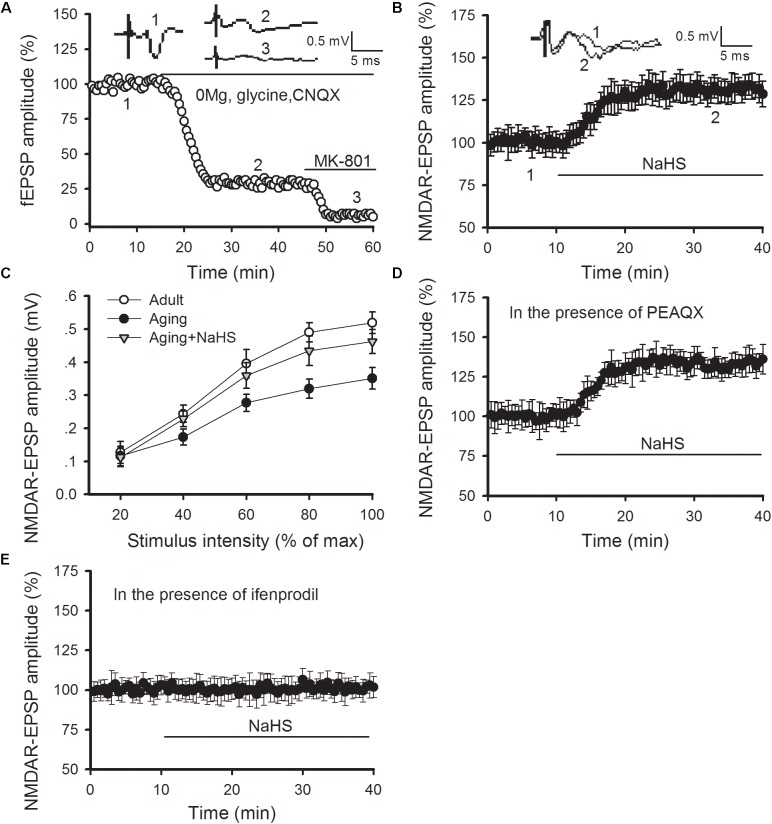
NaHS restores amygdalar NMDAR-mediated synaptic responses by regulating GluN2B-containing NMDAR function in aged rats. (A) NMDAR-mediated EPSPs in the thalamo-LA pathway were isolated by pharmacological intervention. Treatment with MK-801, an NMDAR non-competitive inhibitor, showed complete inhibition of EPSPs. (B) NaHS (75 μM) in slices obtained from aged rats increased the amplitude of NMDAR-EPSPs in the thalamo-LA pathway (n = 7 slices). (C) As shown by input–output curves, NaHS increased the amplitude of NMDAR-EPSPs to that of healthy adult controls in the slices from aged rats (p < 0.05 vs. aging alone) (n = 5 slices per group). (D) PEAQX (0.4 μM) pre-treatment did not impact the effect of NaHS on NMDAR-mediated EPSPs in aged rats (n = 6 slices). (E) Ifenprodil (3 μM) pre-treatment inhibited the action of NaHS on NMDAR-mediated EPSPs in aged rats (n = 6 slices). All data are expressed by mean ± SEM.